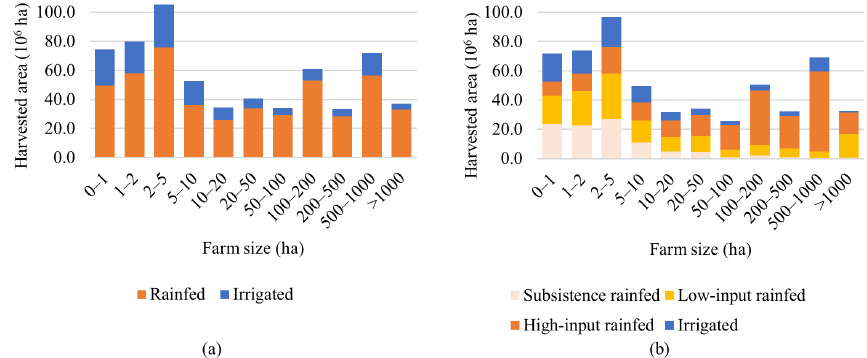
Figure 4. The distribution of irrigated and rainfed farming systems per farm size according to our farm-size-specific and crop-specific harvested area datasets based on the GAEZv4 crop map (a) and the SPAM2010 crop map (b) . Note, SPAM2010 further divides rainfed farming system into low-input, high-input, and subsistence rainfed farming